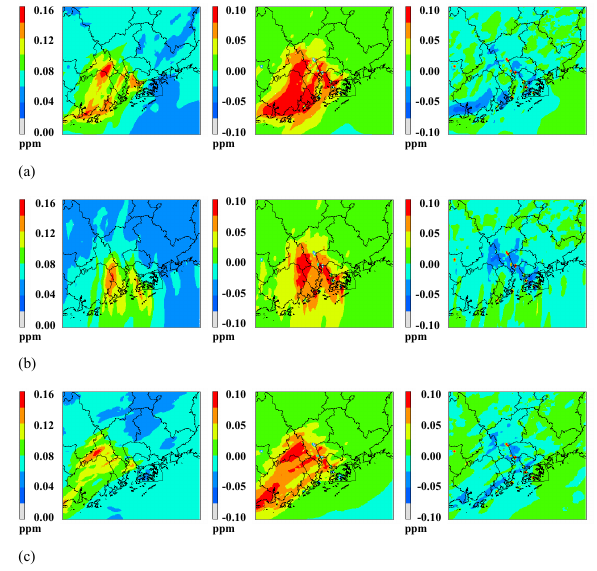
Fig. 11. Regional distributions of O 3 concentrations at 15:00LST (left) and the accumulated contributions of gas-phase chemistry (center) and physical transport (right) from 09:00 to 15:00 LST over the depth of layers 1 to 7 on (a) 16 October, (b) 19 October, and (c) 22 October